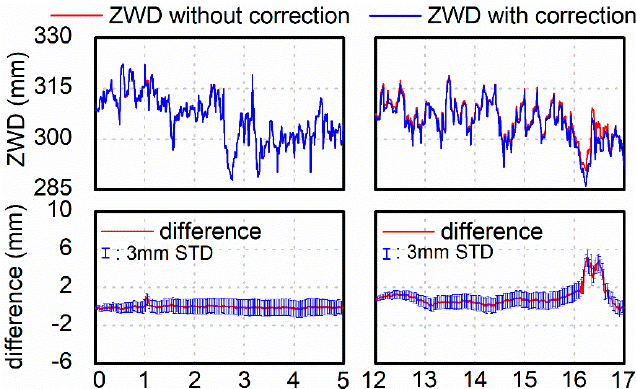
Figure 4. The zenith wet delay (ZWD) estimates ( top ) with and without higher-order ionospheric (HOI) corrections and their differences with error bars ( bottom ) for station YKRO on DOY 239 in 2017 during the daytime and night ‐ time.